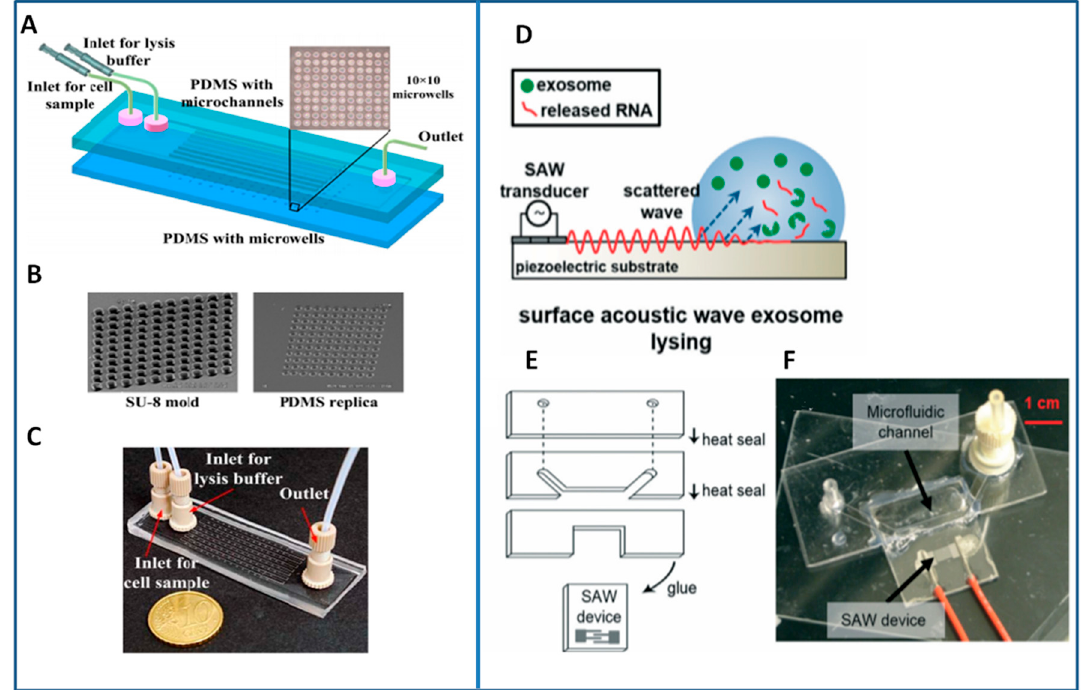
Figure 10. ( A ) Diagram of the microfluidic chip proposed by Jen and colleagues able to sort single cells thanks to polydimethylsiloxane (PDMS) microwells ( B ) obtained by soft lithography from an SU8 hard master; ( C ) Picture of the chemical lysis device reproduced with permission from reference [208]; ( D ) Operation mode of the SAW-based lysis module developed in the work of Taller et al., made by a multilayer structure ( E ) of polycarbonate on a Lithium niobate substrate with SAW interdigited electrodes; ( F ) Picture of the exosomes lysis module D, E, and F portion reproduced with permission from reference [211].